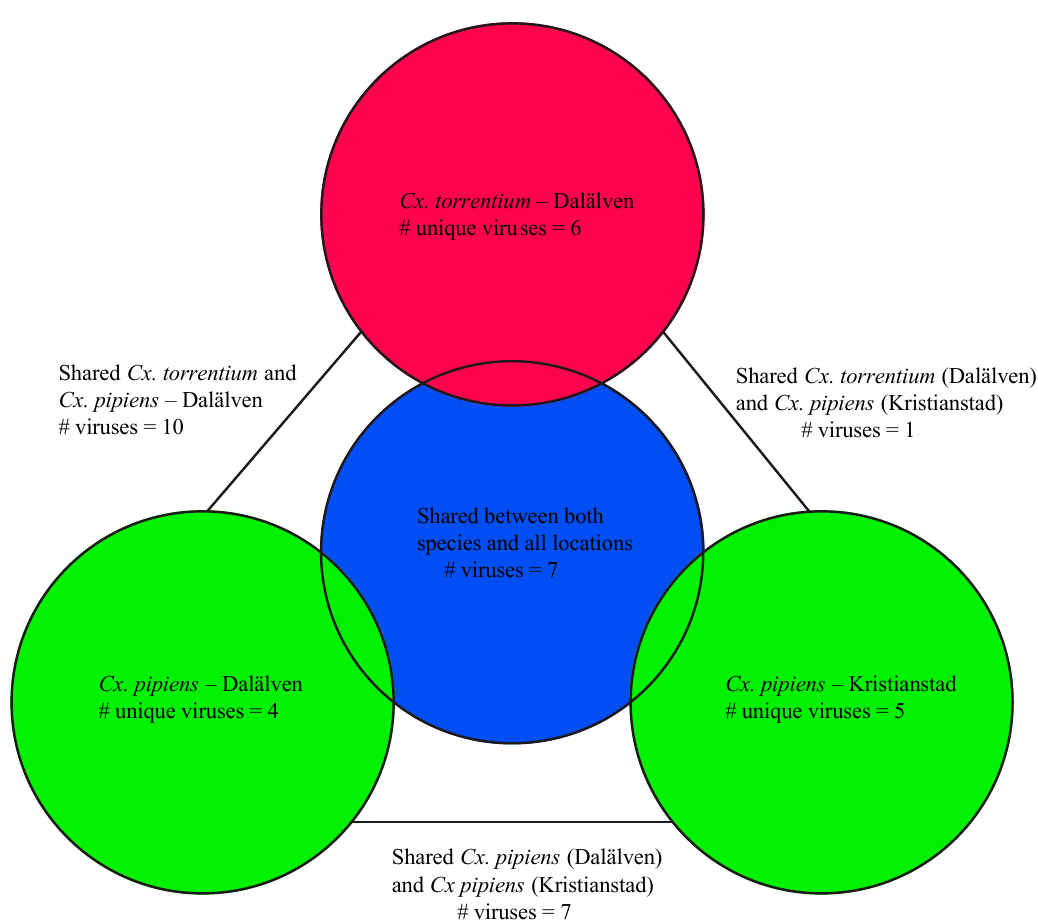
Figure 3. Venn diagram showing the number of unique and shared viruses per location per mosquito